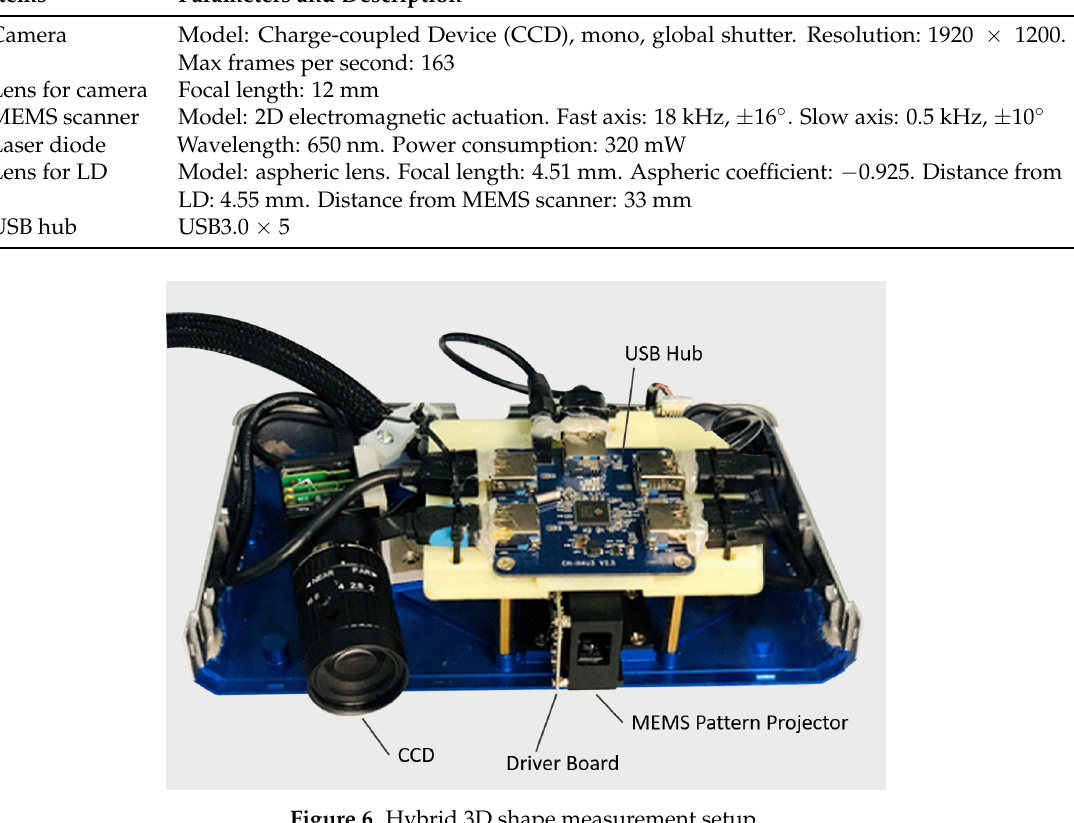
Figure 6. Hybrid 3D shape measurement